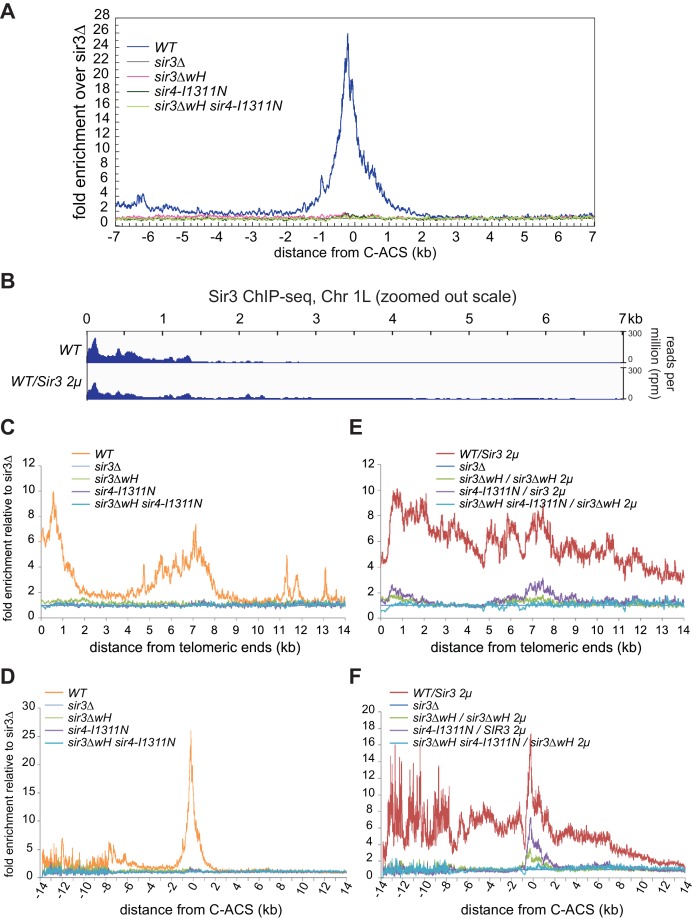
The requirement of Sir3wH and Sir4CC for the association of Sir3 with heterochromatin in vivo.(A) Ensemble plot of Sir3 ChIP-seq signals with endogenous Sir3 expression level, from 30 subtelomeres, excluding TEL01R and TEL13R, aligned at C-ACS. Negative values are towards chromosome end, and positive values are towards centromere. (B) Normalized ChIP-seq read densities for Sir3 and overexpressed Sir3 (Sir3 2 µ) at the left telomere of chromosome 1 (Chr 1 L). Full-scale plot for comparison with Figure 6A. (C, E) Ensemble plots of Sir3 ChIP-seq signals, without (C) and with (E) Sir3 overexpression, from 30 subtelomeres, excluding TEL01R and TEL13R, aligned at chromosome ends. ChIP signal at all 30 subtelomeric regions was summed up, normalized to the sir3Δ sample, and plotted as a function of distance from chromosome end. (D, F) Ensemble plots of Sir3 ChIP-seq signals, without (D) and with (F) Sir3 overexpression, from 30 subtelomeres, excluding TEL01R and TEL13R, aligned at C-ACS. Negative values are towards the chromosome end, and positive values are towards the centromere. ChIP signal at all 30 subtelomeric regions was summed up, normalized to the signal from sir3Δ cells, and plotted as a function of distance from C-ACS.